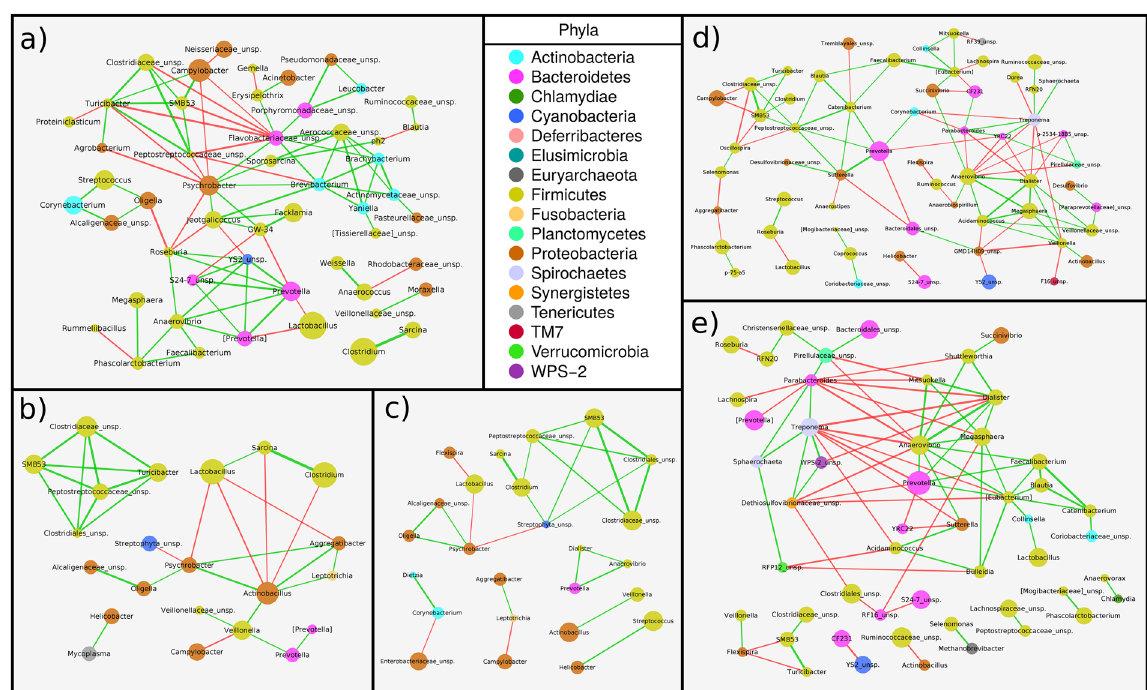
Figure 4. SparCC 55 PCIT 56 (SPCIT 13 ) prokaryotic genus network for partial correlations with an absolute value above 0.65 between log-transformed genus abundances performed in the ( a ) duodenum, ( b ) jejunum, ( c ) ileum, ( d ) proximal colon, and ( e ) distal colon. The width of the edge represents the degree of the correlation (wider if it is higher), and the colour shows the sign of the correlation: negative (red) and positive (green). The area of the node is proportional to the relative abundance of the prokaryotic genus. The suggested annotation for some genera is enclosed in square